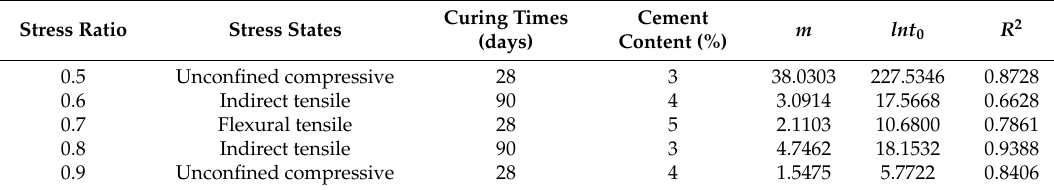
Table 8. Regression coefficient and correlation coefficient for the Weibull distribution test.